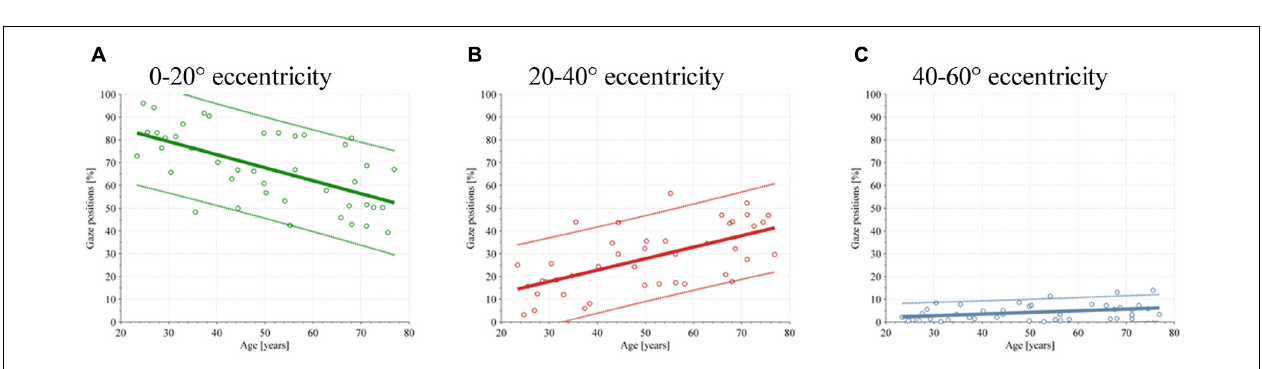
FIGURE 5 | Scatterplot of the reaction time depending on age. Each subjects’ performance is shown with circles, linear broken-line regression with colored solid lines, and the 90% confidence interval is shown with dotted lines and the polynomial regression as a solid black line. (A) Reaction time at ε H = 10 ◦ . (B) Reaction time at ε H = 30 ◦ . (C) Reaction time at ε H = 50 ◦ .